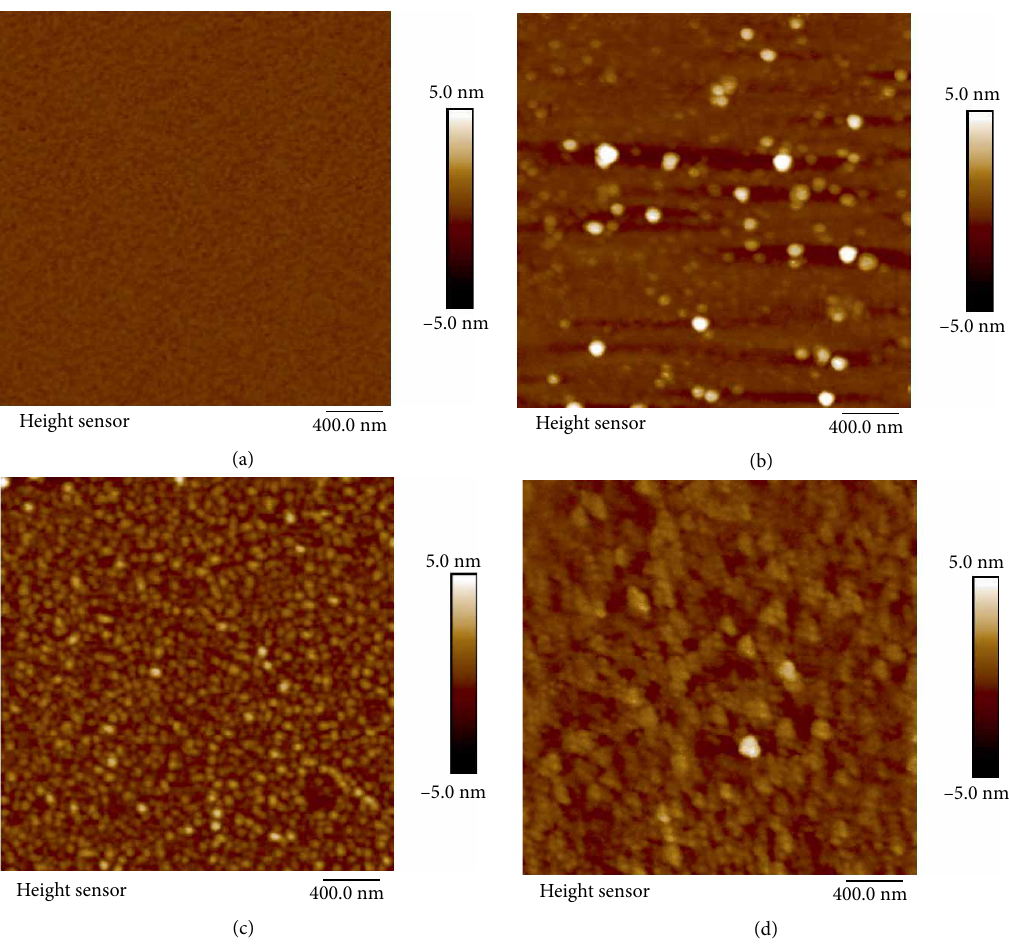
Figure 2: AFM images of different samples: (a) silica, (b) silica after adsorption of HMPAM, (c) asphaltene, and (d) asphaltene after adsorption of